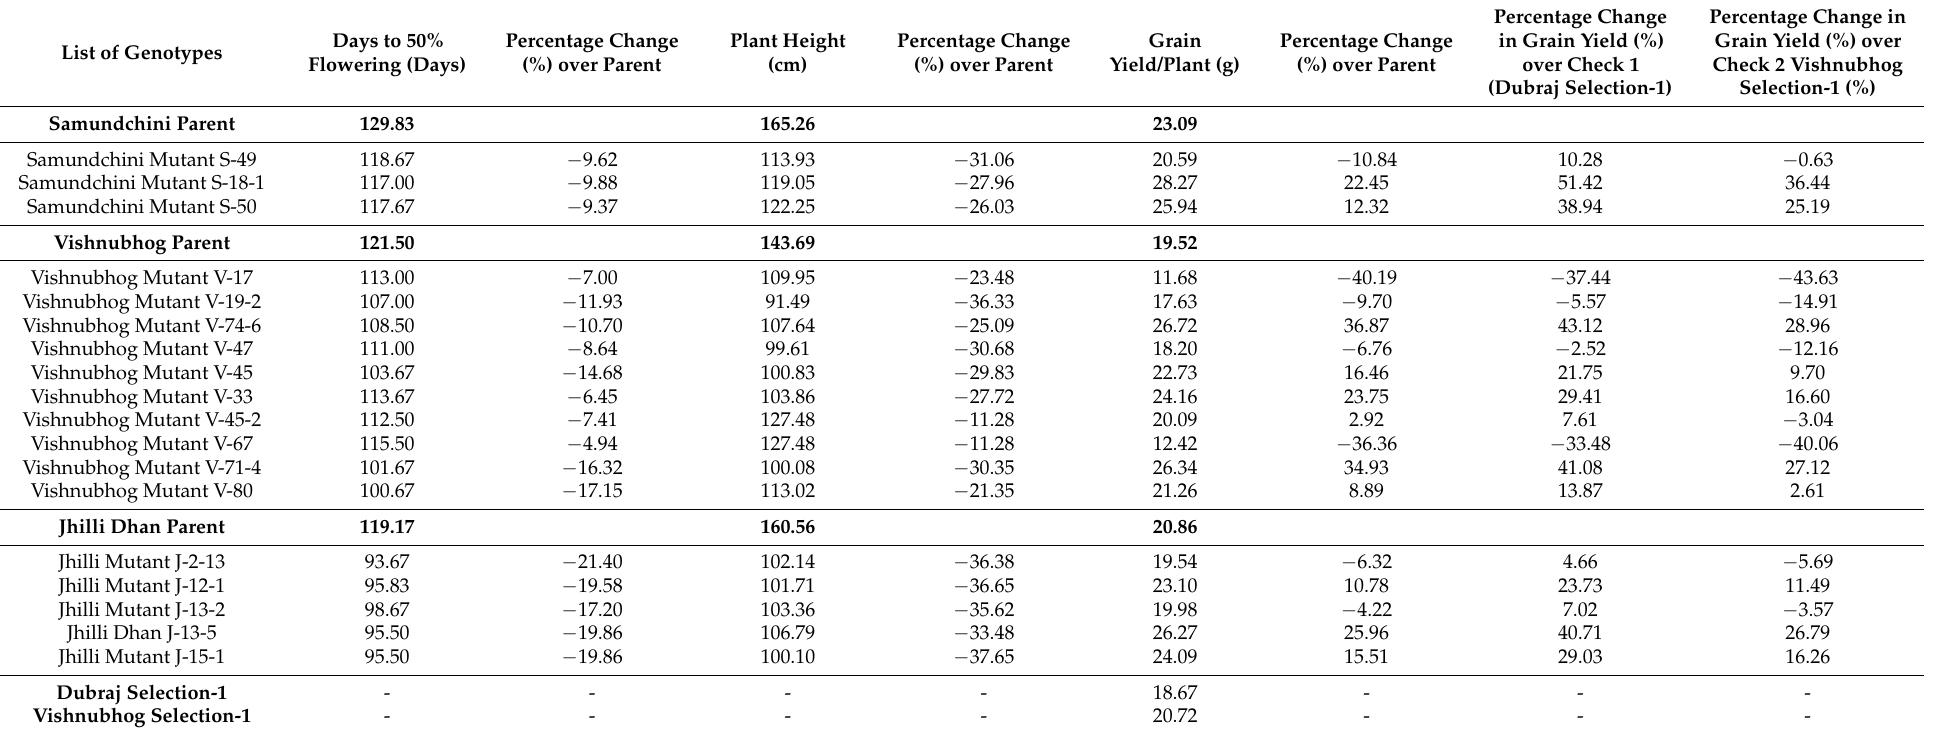
Table 2. Percentage change in days to 50% flowering, plant height and grain yield/plant of mutants over the corresponding parents and